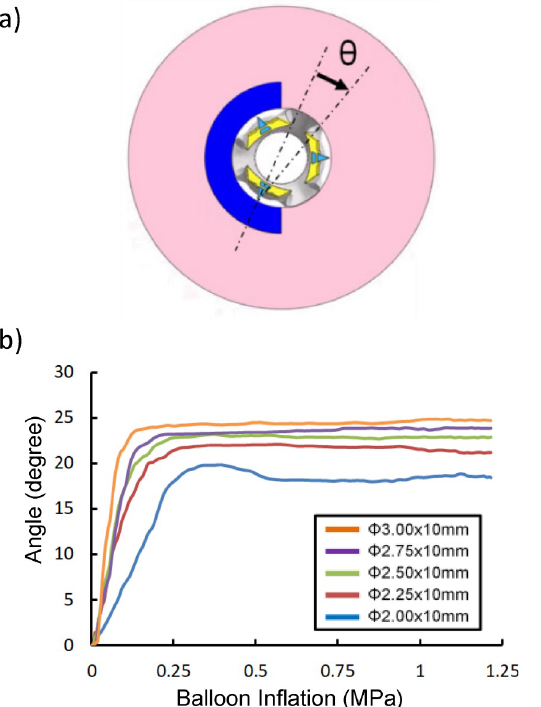
Fig 8. Changes in the angles of the blades during inflation. (a) Change in the angle of the blade facing the calcification model during expansion. (b) Comparison of angle changes among 2, 2.25, 2.5, 2.75, and 3 mm cutting balloons for the entire pressure